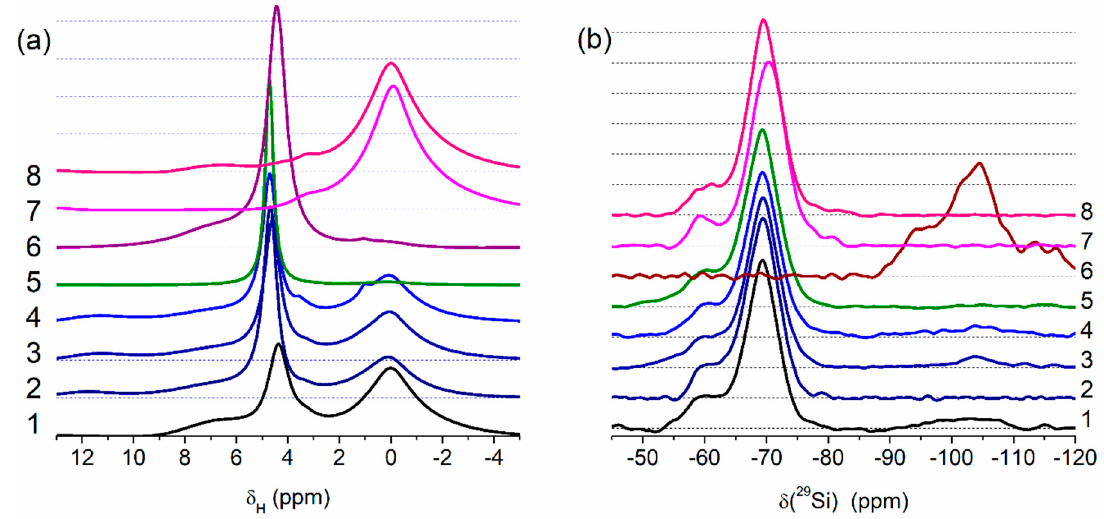
Figure 4. Solid state NMR spectra of ( a ) 1 H (MAS) and ( b ) 29 Si (CP / MAS) for PMS, A-300 and their blends (curve numbers correspond to sample numbers) (Q n corresponds to Si(OH) 4 − n (OSi ≡ ) n at n = 2 ( − 91~ − 93 ppm), 3 ( − 99~ − 102 ppm), and 4 ( − 109~ − 111 ppm); T 3 ( − 70 ppm) corresponds to ( ≡ SiO) 3 SiCH 3 ) and T 2 ( − 60 ppm) corresponds to ( ≡ SiO) 2 Si(OH)CH 3 ), see Table S1).